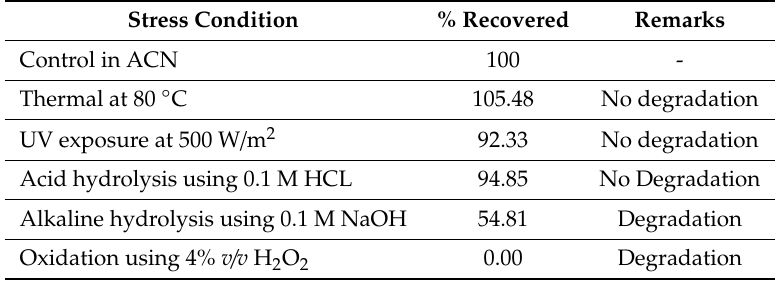
Table 9. Forced degradation data for CLA following exposure to stress conditions for 12 h.